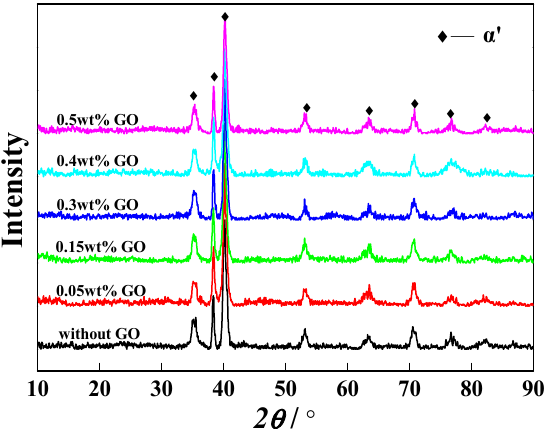
Figure 5. XRD pattern of the mixed powders with different addition amounts of GO.